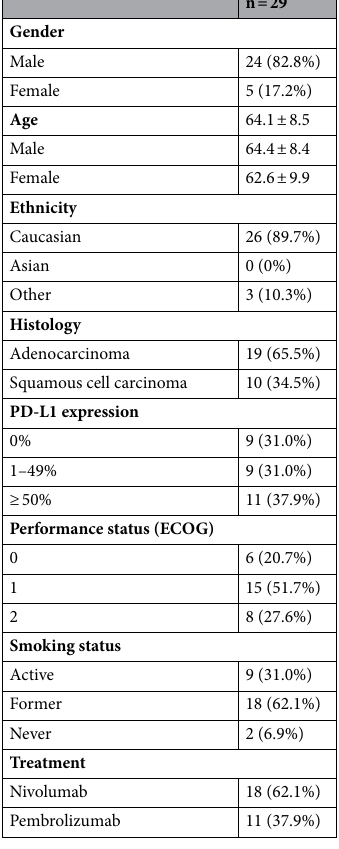
stratified into three groups (0%, 1–49% and ≥ 50%) with about one third of patients in each group. Most patients were active or former smokers and about two thirds received nivolumab therapy, whereas the remaining patients were treated with pembrolizumab. Baseline characteristics of the study cohort are summarized in Table 2. Pre‑therapeutic inflammatory scores. First, we tested whether standard blood values indicating acute inflammation and scores calculated from these values correlate with response to immunotherapy or PFS. NLR was significantly elevated in patients with primary progressive disease (p = 0.003, Fig. 1A). We performed a ROC analysis to determine a NLR value of 5.2 to be the best cutoff for response in our cohort. Patients with NLR equal or greater than 5.2 showed significantly reduced PFS under checkpoint inhibitor treatment (median PFS 7.43 weeks [95% CI 3.37–11.49] vs. 40.0 weeks [95% CI 16.01–64.0], p < 0.001) (Fig. 1D). SII was significantly increased in patients showing primary progression under immunotherapy (p = 0.011, Fig. 1B). The best cut-off value for SII regarding response was 1217. Patients with SII equal or higher than 1217 had significantly reduced PFS compared with patients harboring lower values (median PFS 7.51 weeks [95% CI 3.26–11.88] vs. 40.0 weeks [95% CI 11.48–68.52], p = 0.001) (Fig. 1E). PLR was revealed to be significantly increased in patients responding to immunotherapy (p = 0.035, Fig. 1C). However, PLR levels did not show any impact on patients’ survival. Patients responding on immunotherapy showed a trend to lower CRP levels, although this difference was not statistically significant. However, choosing the optimal cut-off (4.3 mg/dl) in our cohort, showed a significant PFS advantage in patients with low CRP values (median PFS 14.71 weeks [95% CI 4.18–25.25] vs. 7.57 weeks [95% CI 2.71–12.44], p = 0.043) (Fig. 1F). mGPS did not discriminate between response and progressive disease or subgroups with better survival. Pre‑therapeutic cytokine profile. Interleukin-6 (IL-6) was significantly increased in patients show- ing primary progression under immunotherapy (p < 0.001, Fig. 2A). The best cut-off value for IL-6 regarding response was determined to be 11.6 pg/ml. Patients with IL-6 equal or higher than 11.6 pg/ml had significantly reduced PFS compared with patients harboring lower values (median PFS 5.14 weeks [95% CI 0.95–9.33] vs.